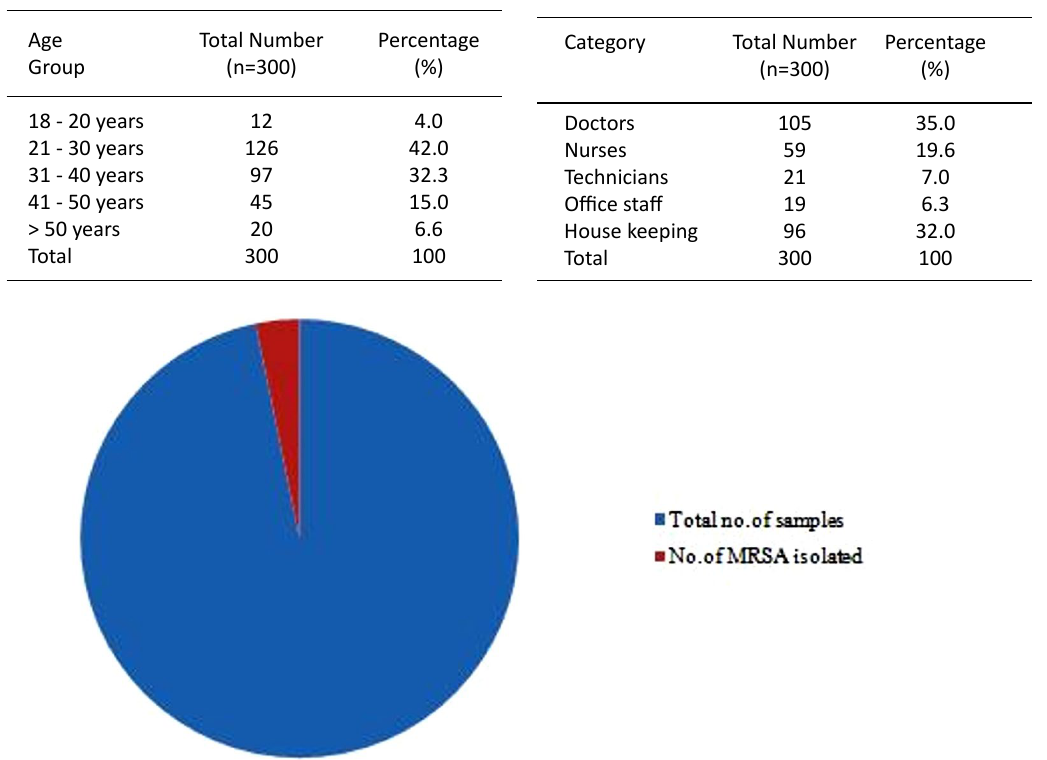
Table 2. Age distribution among the health care Table 3. Distribution of health care workers